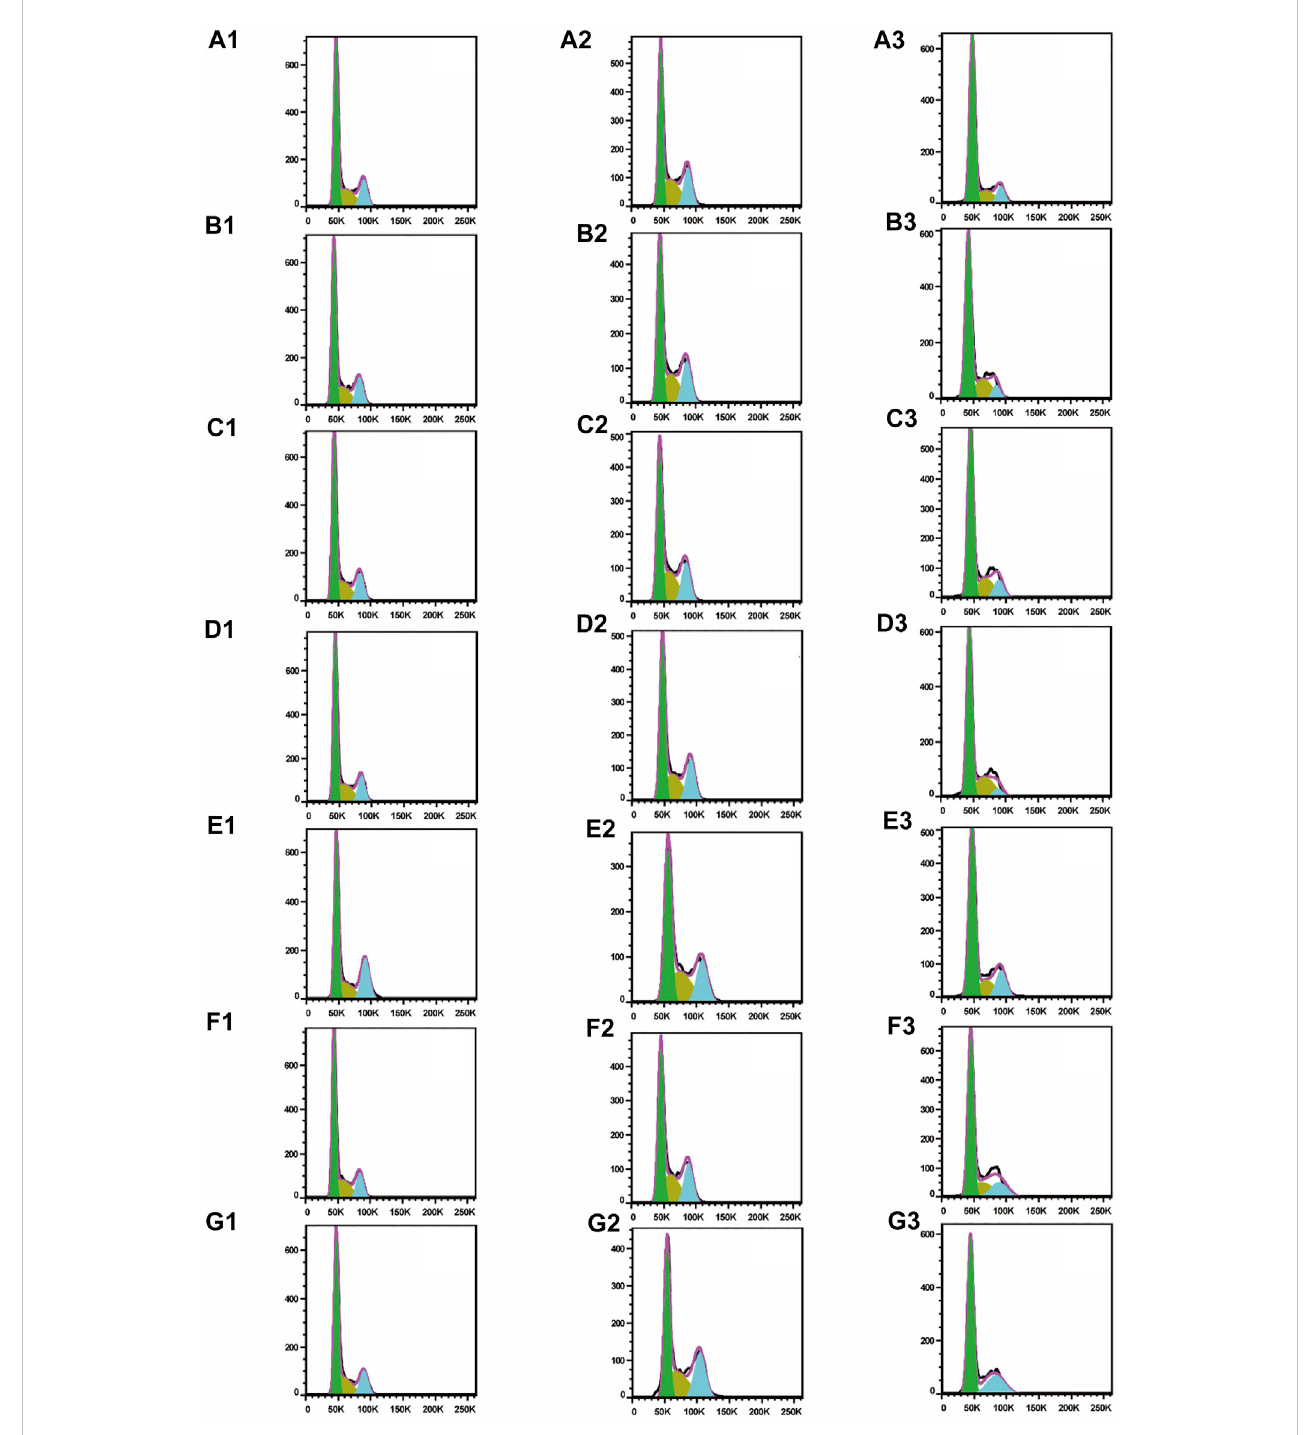
FIGURE 2 All six isolated saponins induce cell cycle arrest in three cancer cell lines. (A1 – G1), A549 cells. (A2 – G2), SMMC-7721 cells. (A3 – G3), HepG2 cells. DMSO wasusedasanegativecontrol(An).Saponin 1 (Bn),saponin 2 (Cn),saponin 3 (Dn),saponin 4 (En),saponin 5 (Fn),andsaponin 6 (Gn),n=1,2,3.ForSMMC-7721 and HepG2 cell lines, each saponin was added at 1 μ M. For A549 cells, saponins 1 and 5 were added at 0.5 μ M; the other four saponins were added at 1 μ